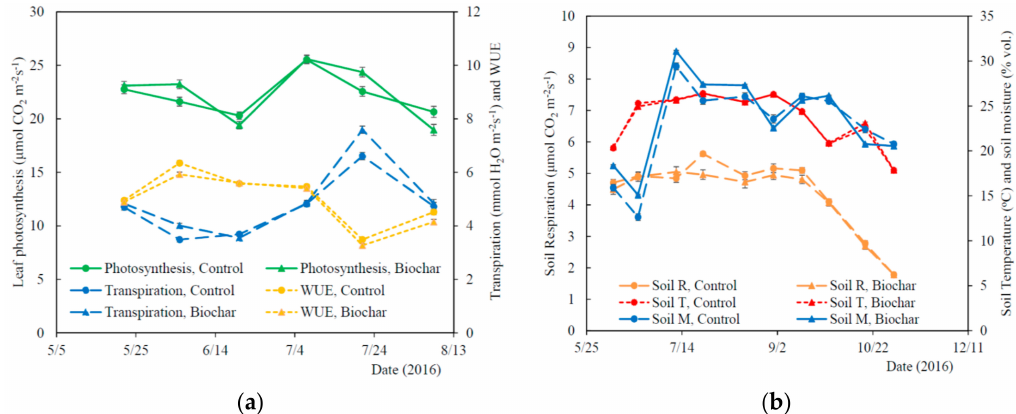
Figure 3. Seasonal variations of ( a ) leaf photosynthesis ( µ mol CO 2 m − 2 s − 1 ), transpiration (mmol H 2 O m − 2 s − 1 ), and water use efficiency (WUE, µ mol CO 2 mmol − 1 H 2 O), ( b ) seasonal variations of